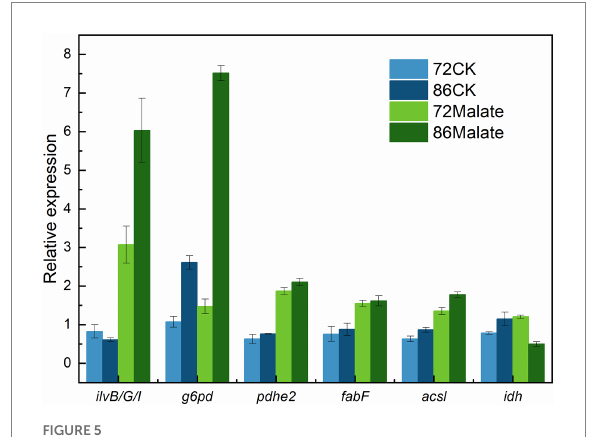
FIGURE 5 Validation of the gene expression profiles of the ilv B , ilv G, ilv I , g6pd, pdhe2, fab F , acsl, and idh genes by quantitative reverse- transcription PCR. Light blue represents the control group at 72 h, which is the expression level of 18 s rDNA; At 86 h, Dark blue represents the control group. While dark green indicates each gene’s expression at 86 h, light green indicates each gene’s expression at 72 h.